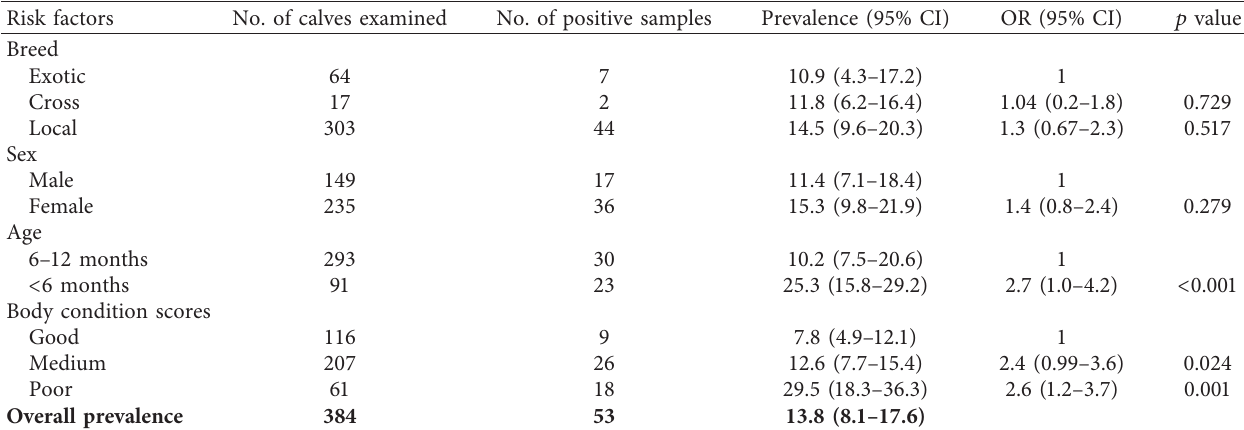
Table 2: Logistic regression analysis of risk factors associated with Cryptosporidium infection.